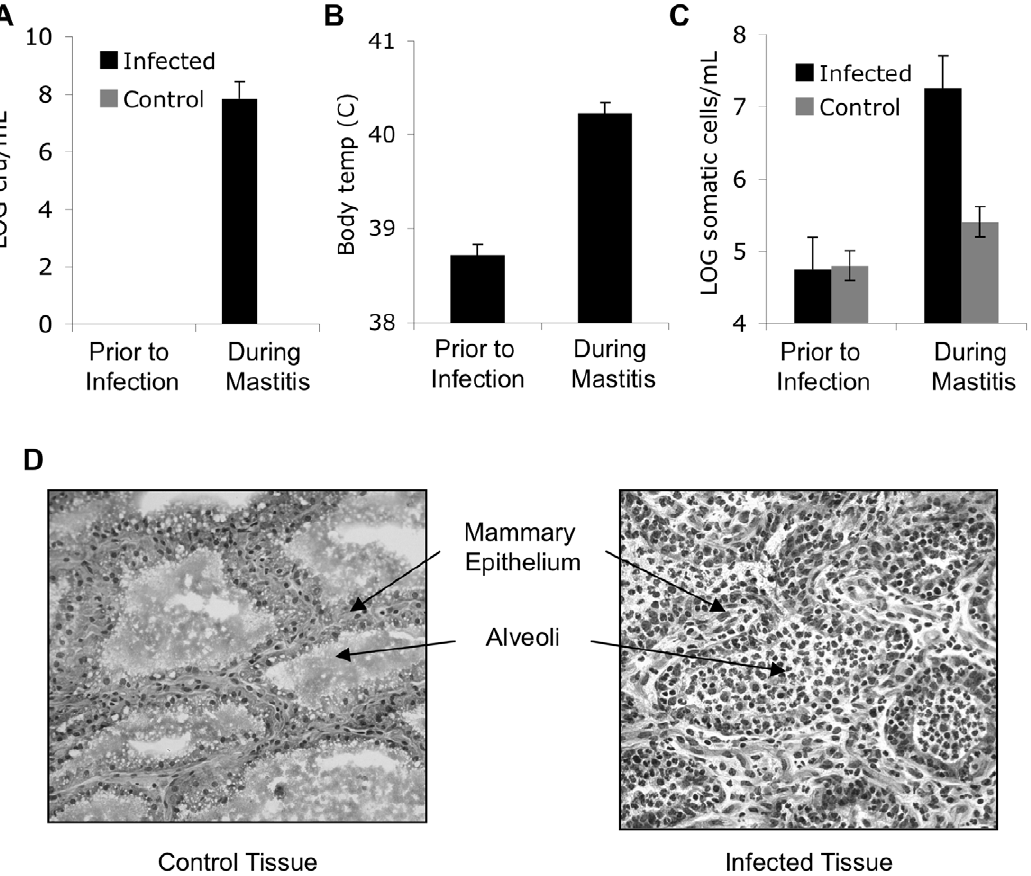
Figure 1. Intra-mammary infection with Streptococcusuberis . Five hundred CFU of S. uberis strain 0140 were infused into the mammary glands of 8 healthy cows. The contra-lateral glands were infused with 3 mL of PBS and served as the controls. Prior to infection, all glands were free of bacteria. The average CFU of S. uberis in milk ( A ), rectal temperatures ( B ), and number of somatic cells in milk ( C ) prior to and during infection are shown. Error bars represent the SE. ( D ) Representative tissue sections at 20X magnification from the control and infected mammary gland.